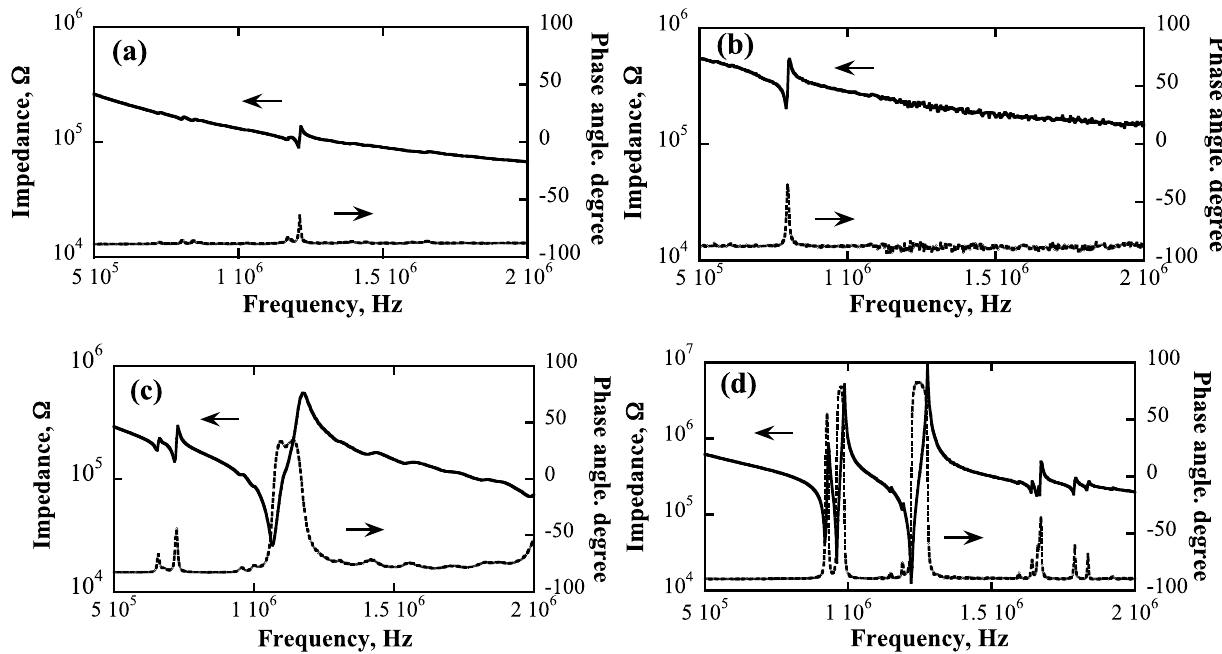
Figure 11. Frequency dependence of impedance and phase angle on ( a ) KN: KNbO ; ( c ) KNRN: (K,Na,Rb)NbO ( b ) KNN: (K,Na)NbO 3 the longitudinal direction of the c -axis, reprinted with permission from [45]. Copyright 2011 Elsevier and Techna Group